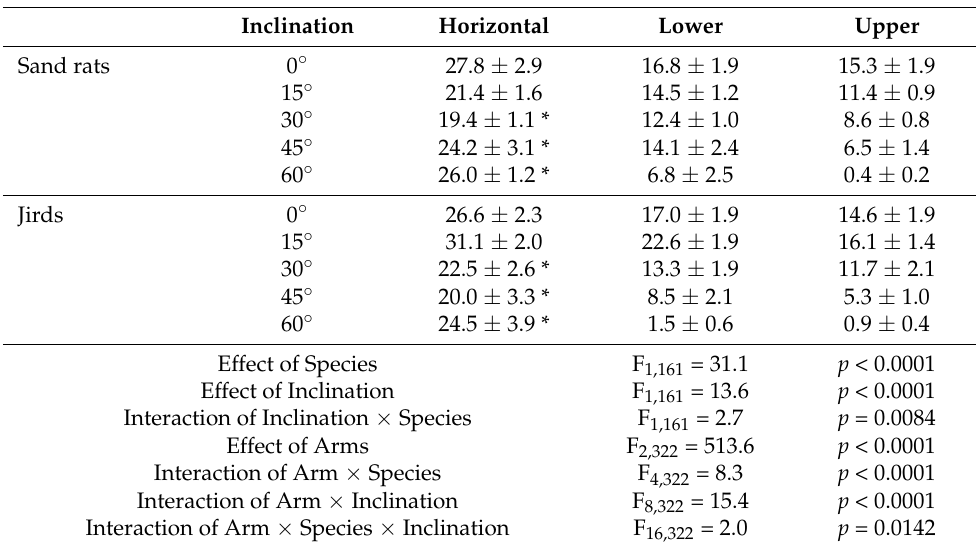
Table 4. Cont. Distance Traveled in Each Arm (m) Inclination Horizontal Lower Upper Sand